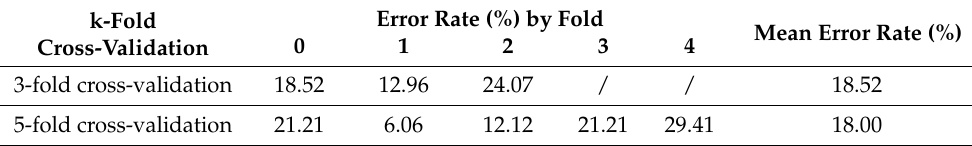
Table 8. The results of 3-fold cross-validation and 5-fold cross-validation.